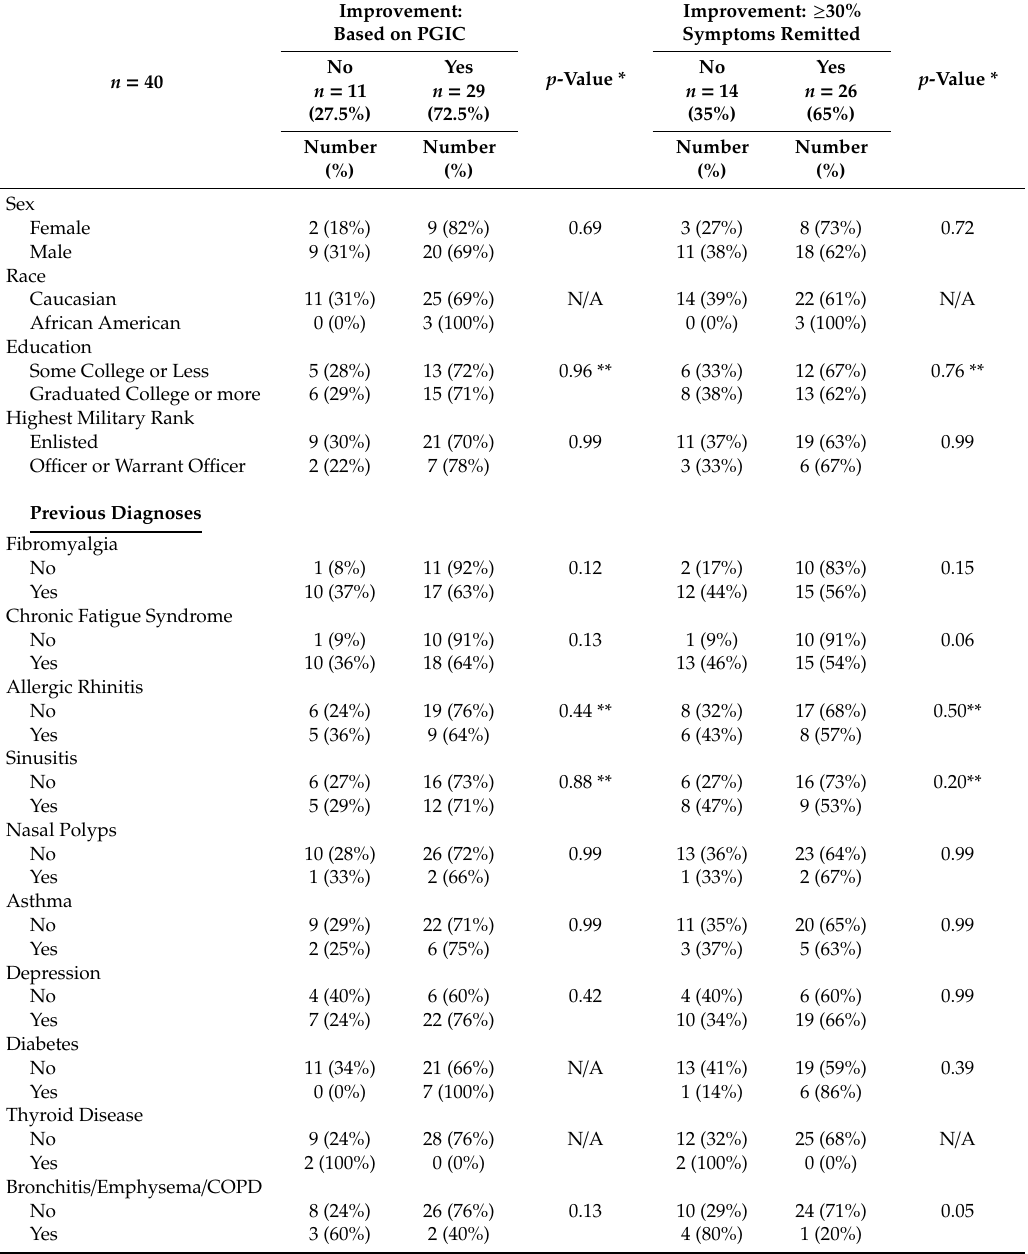
Table 3. Characteristics of those who improved on the diet based on a report of “much” or “very much” improved on the patient global impression of change scale and based on remission of ≥ 30% of their